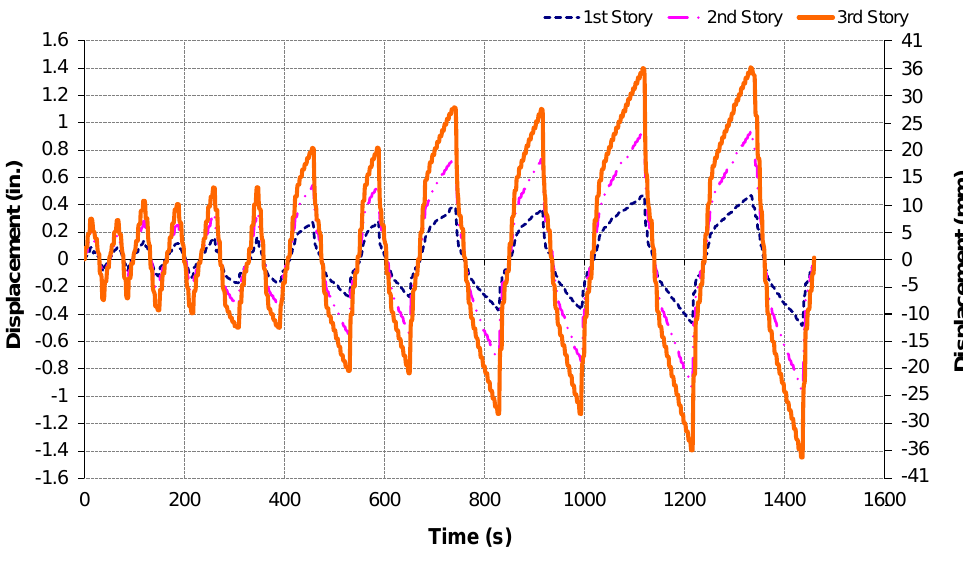
Figure13. Bare frame cyclic test BFCT1 load